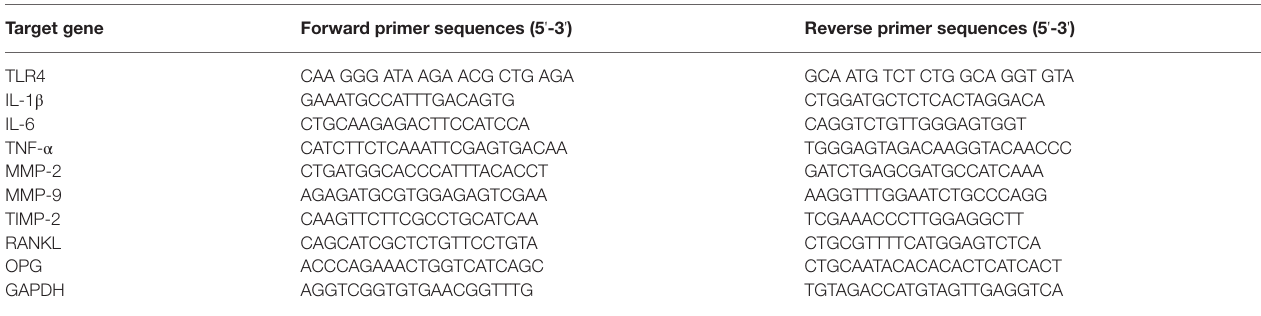
TABLE 1 | Primers used for